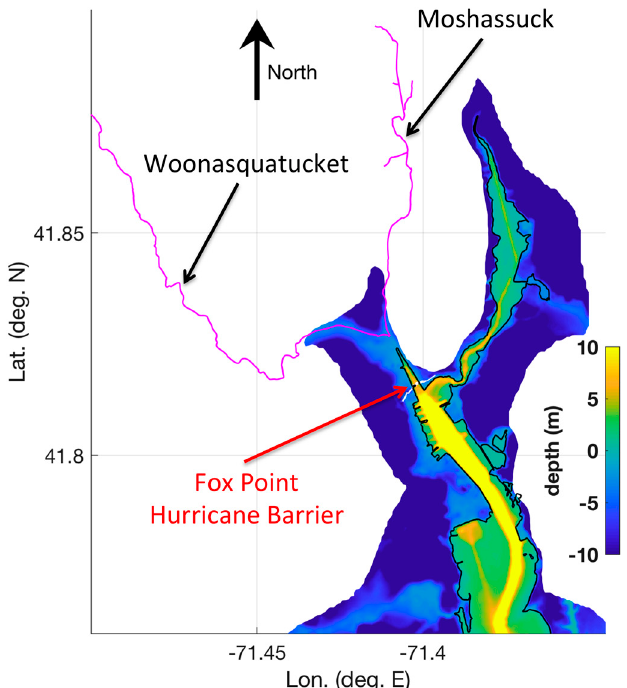
Figure 3. Mesh bathymetry in the Providence area at the northern end of Narragansett Bay. Land elevations are negative in this representation. The two rivers entering the domain to the north of the hurricane barrier are denoted by the magenta lines.